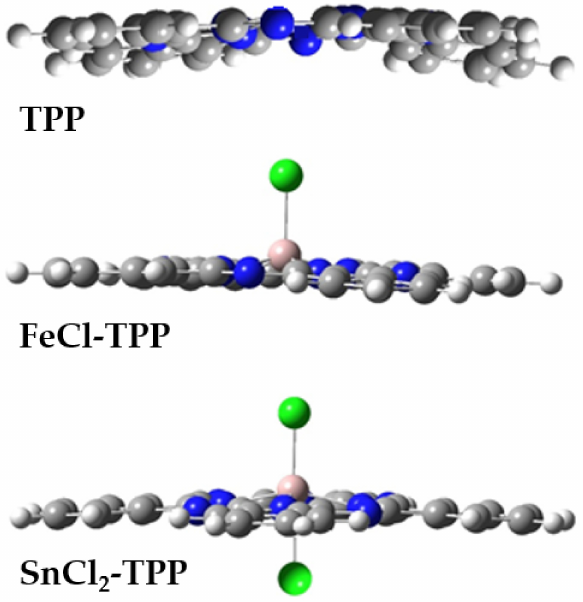
Figure 1. Side view on TPP, FeCl-TPP, and SnCl 2